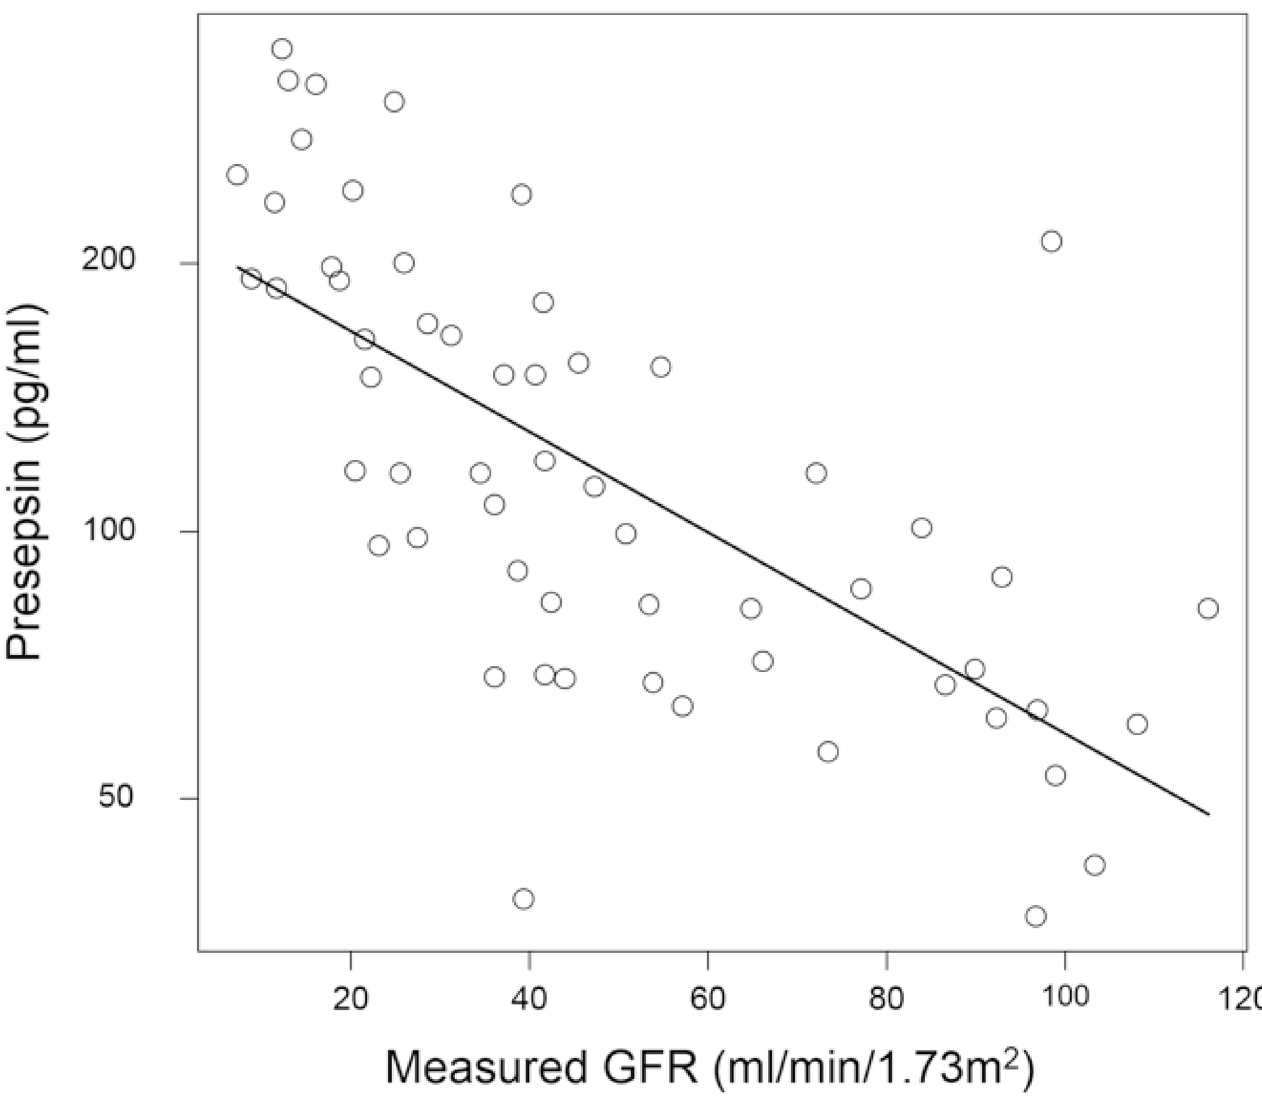
Fig 2. Correlation between the log-transformed presepsin values and measured GFR in patients not receiving hemodialysis. N = 58, Pearson ’ s correlation coefficient = -0.687, 95% CI = -0.803 to -0.521, P <